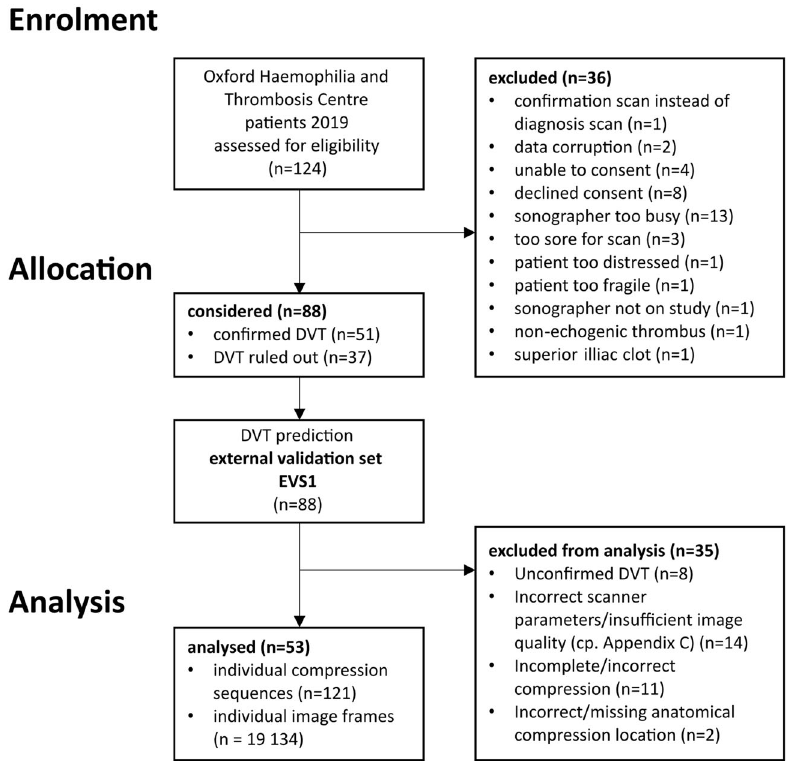
Fig. 1 Consort diagram for study enrolment. Allocation, and analysis in External Validation Set 1 (EVS1).